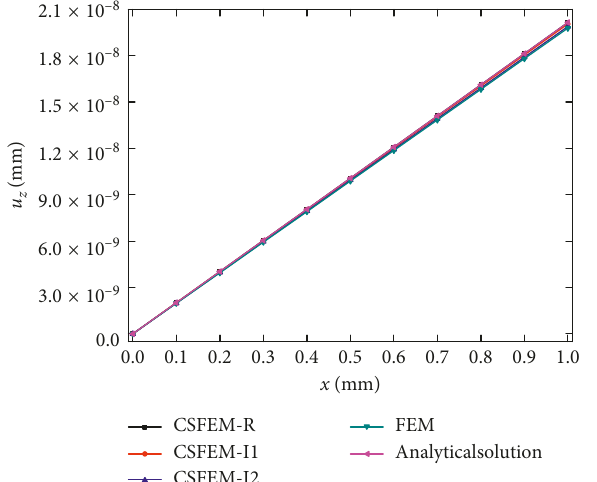
z at the central line